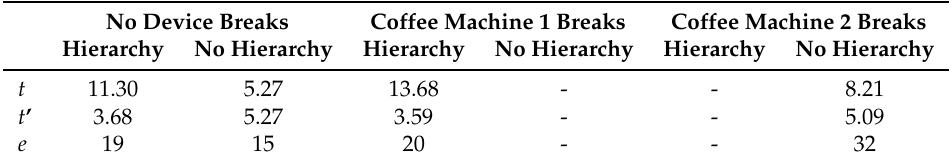
Table 3. Comparison of planning times and number of executed primitive actions for the fetching coffee scenario. t is the total planning time, t’ planning time before the first primitive action is executed, e is number of executed primitive actions. All times are given in seconds and are the average of 5 runs. “No hierarchy” was not affected by coffee machine 1 breaking and “Hierarchical” was not affected by coffee machine 2